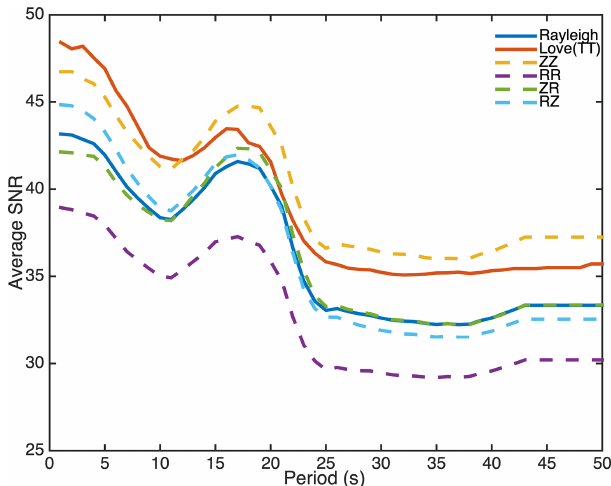
Figure 4. Average signal-to-noise ratio (SNR) for Rayleigh and Love waves for all station pairs. Average SNRs of ZZ, RR, ZR, and RZ are also shown; Rayleigh waves are extracted from these four inter-components. Average SNRs of TT and Love waves are also represented in the figure. Love waves appear on the TT inter-